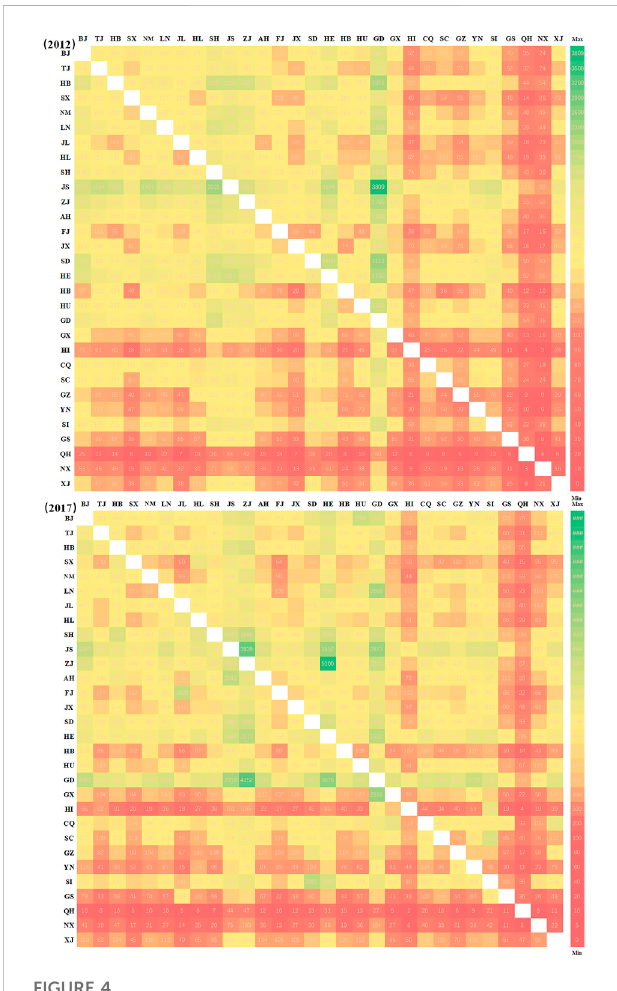
FIGURE 4 Inter-provincial transfer matrix of embodied GDP from 2012 to